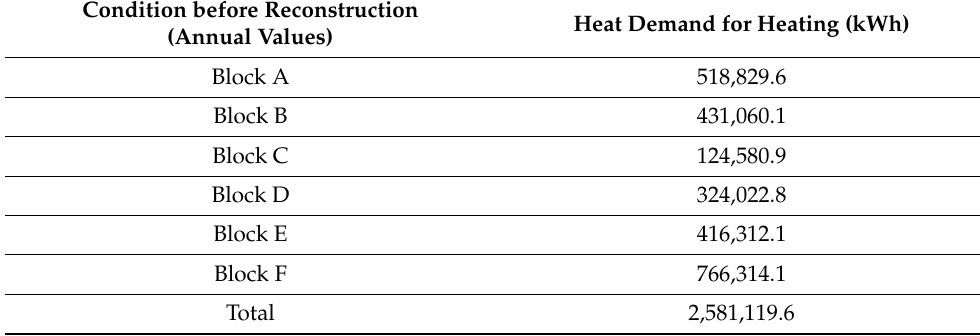
Table 9. Heat demand after reconstruction.